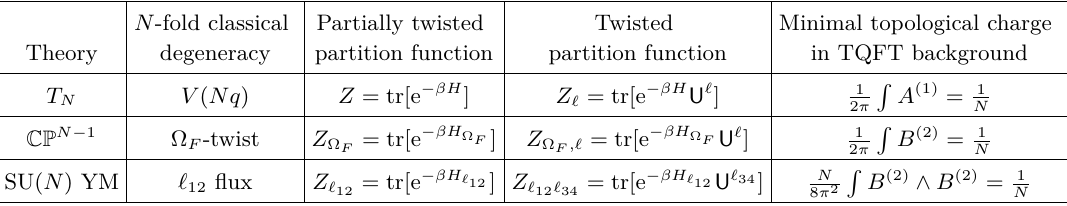
Table 1 . The correspondence between the T N quantum mechanics, C P N − 1 with flavor twisted background, and Yang-Mills with ’t Hooft flux